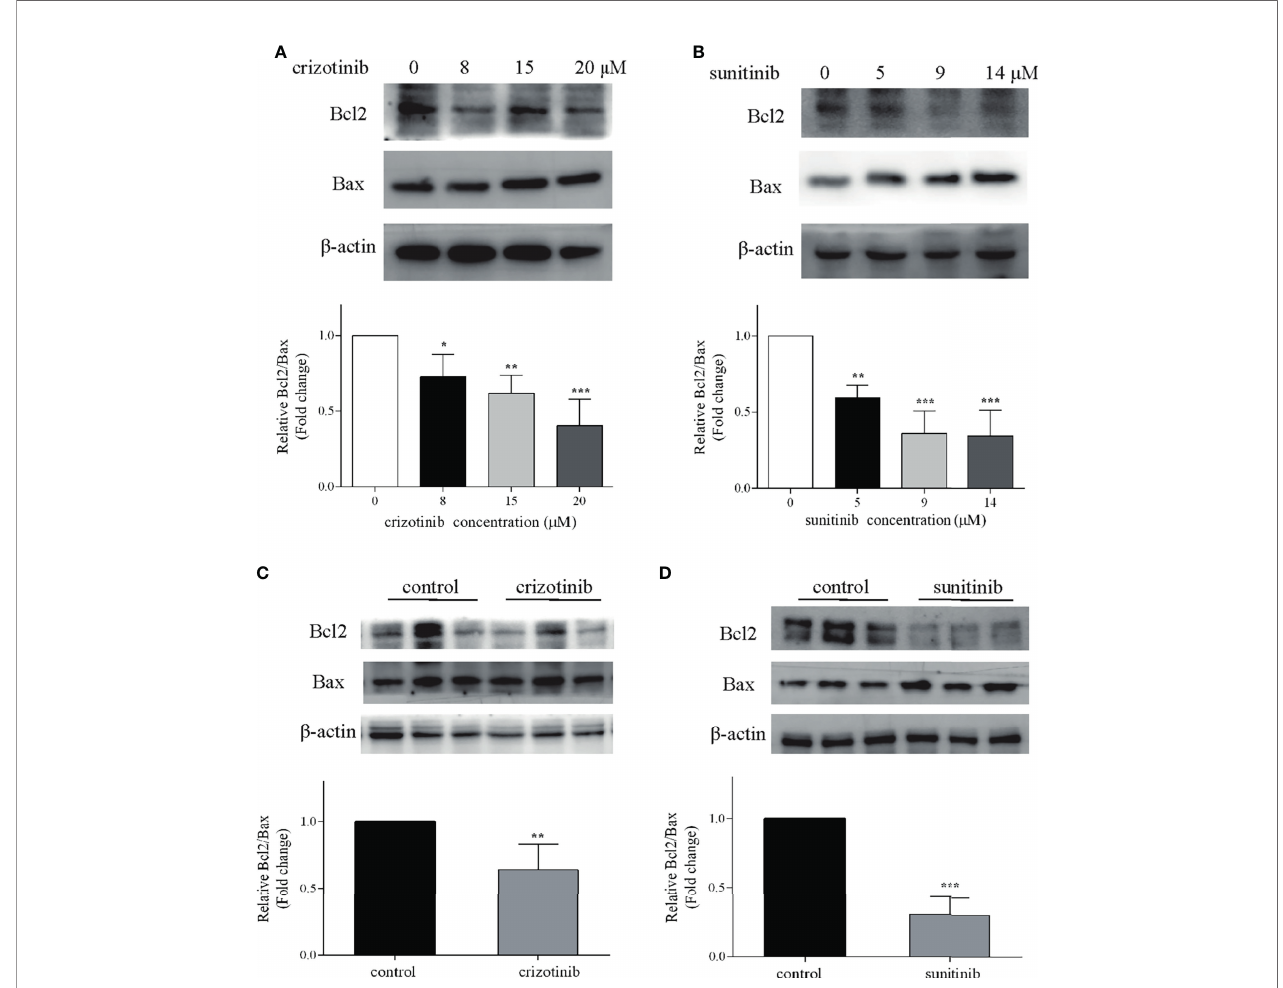
FIGURE 9 | Crizotinib or sunitinib treatment altered the levels of Bcl2 and Bax in HepG2 cells and in liver tissue. (A, B) Protein levels of Bcl2 and Bax in HepG2 cells treated with crizotinib or sunitinib for 24 h (n = 3). (C, D) Protein level of Bcl2 and Bax in liver tissue in mice treated with crizotinib or sunitinib for 4 weeks (n = 6). *P < 0.05, **P < 0.01 or ***P < 0.001 (the crizotinib or sunitinib alone vs.